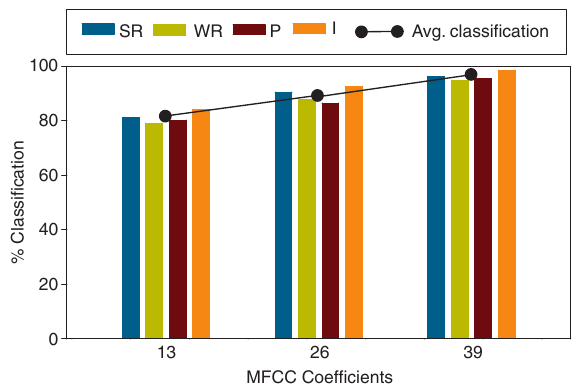
Figure 4: Classification of Dysfluencies for Different MFCC Coefficients.